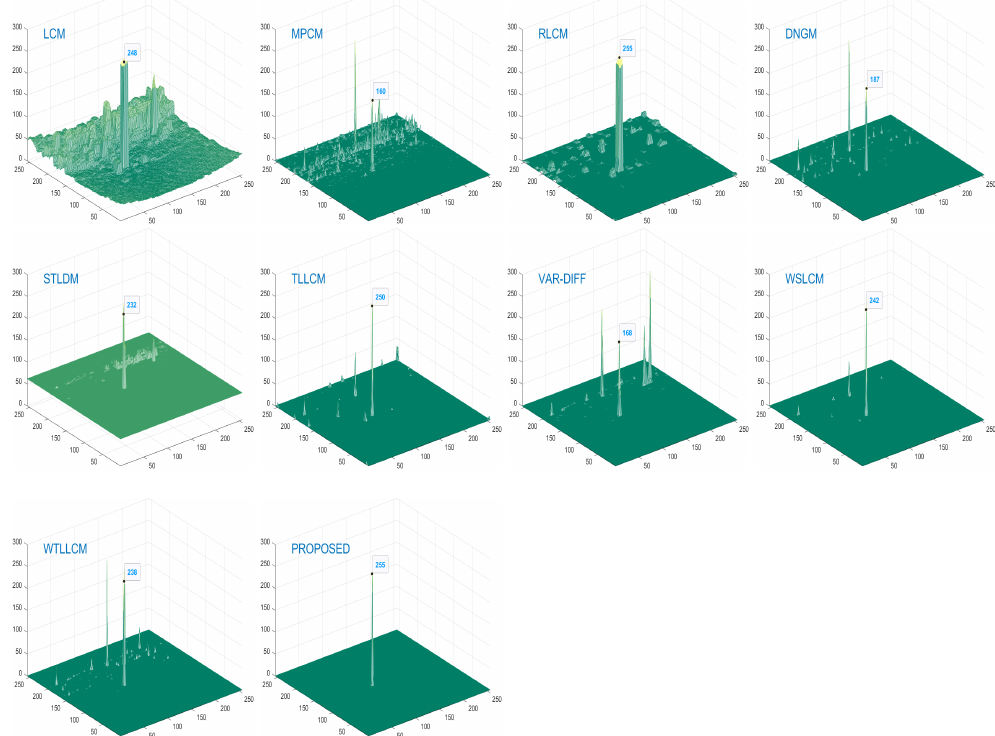
Figure A2. Three-dimensional displays of detection results on one frame in data4. Different subgraphs are the results of different